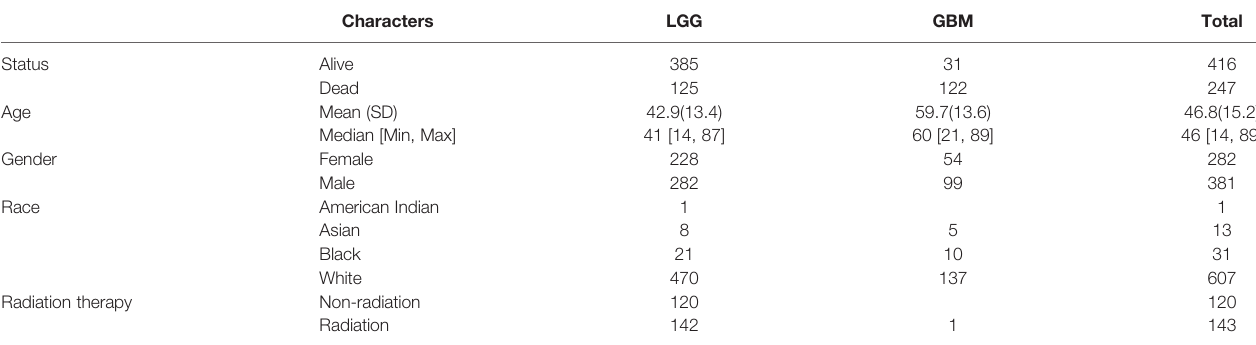
TABLE 1 | Clinical characteristics of patients in TCGA-LGG and GBM